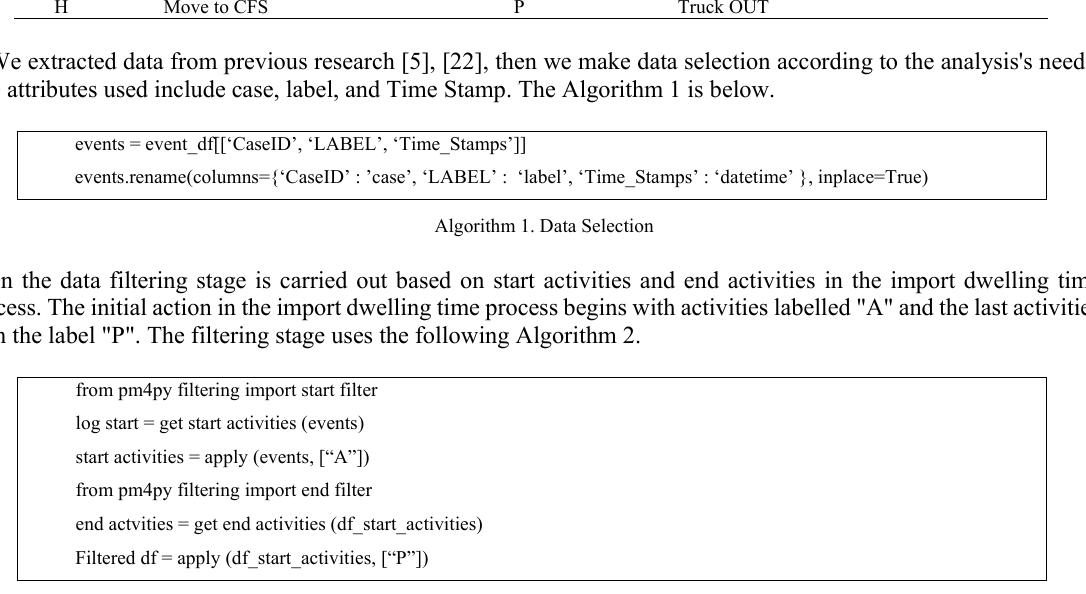
Algorithm 2. Filtering On Start and End Activities